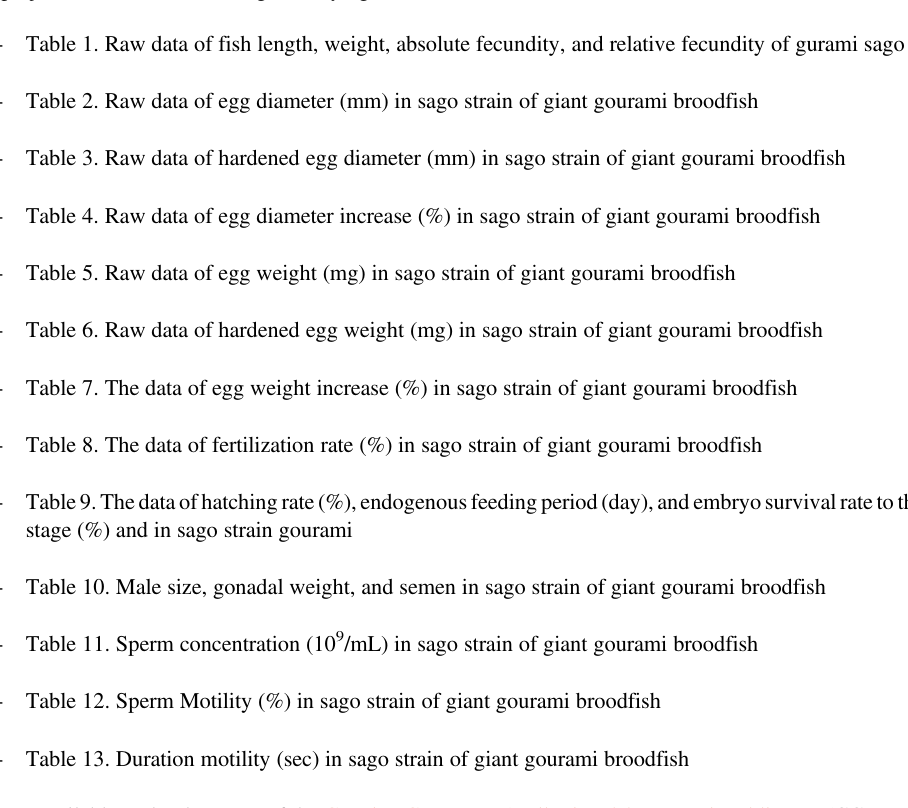
- Table 9.Thedataofhatching rate(%), endogenousfeedingperiod(day),and embryosurvivalratetotheeyed-egg stage (%) and in sago strain gourami